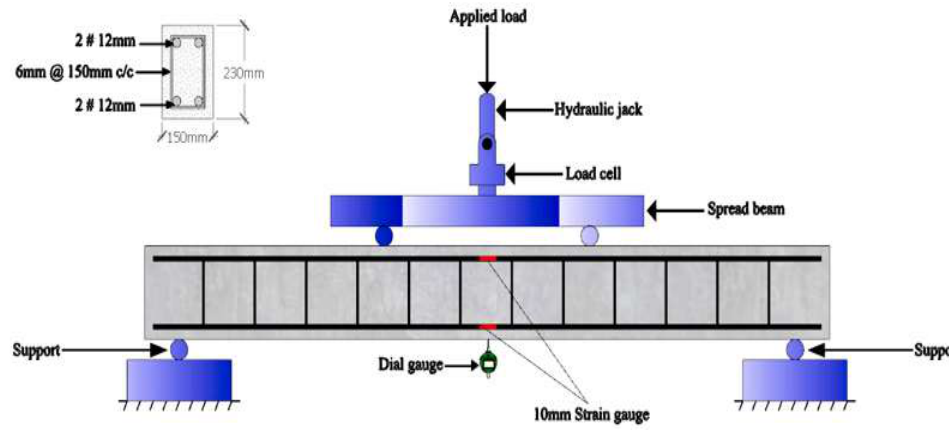
Figure 7. Experimental Setup for the Beam Specimens.